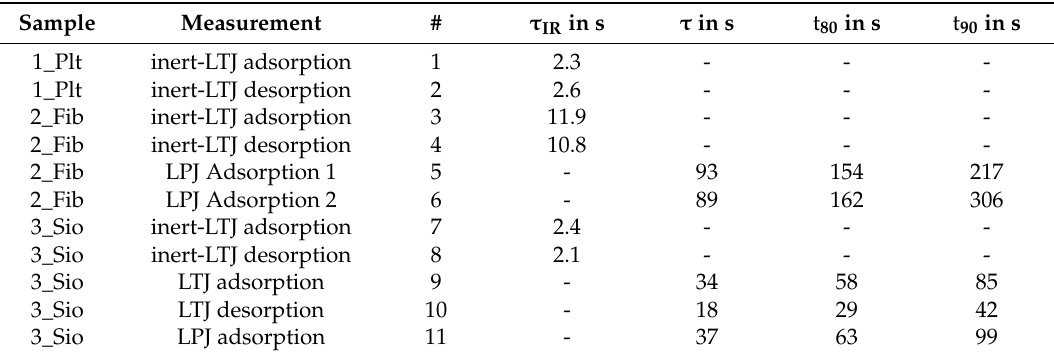
Table 6. Dynamic figures of all